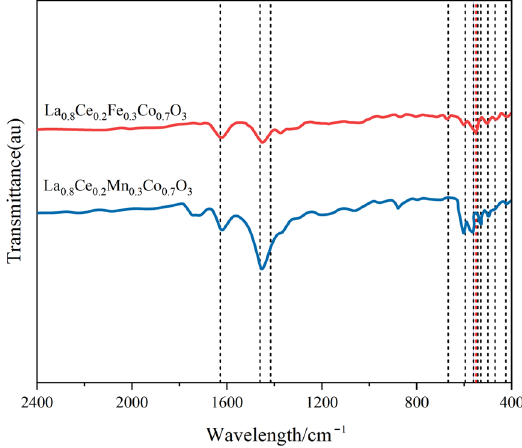
Figure 12. FTIR spectra of La 0.8 Ce 0.2 Fe 0.3 Co 0.7 O 3 and La 0.8 Ce 0.2 Mn 0.3 Co 0.7 O 3 catalyst samples.